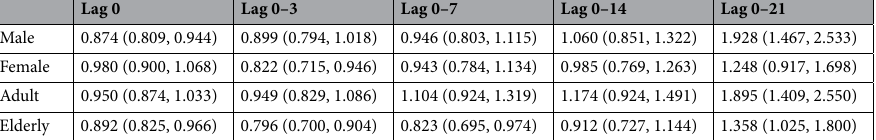
Table 4. For the gender and age subgroup, the cumulative effect of high DTR had an impact on the hospital admissions for CVD along the lag days.